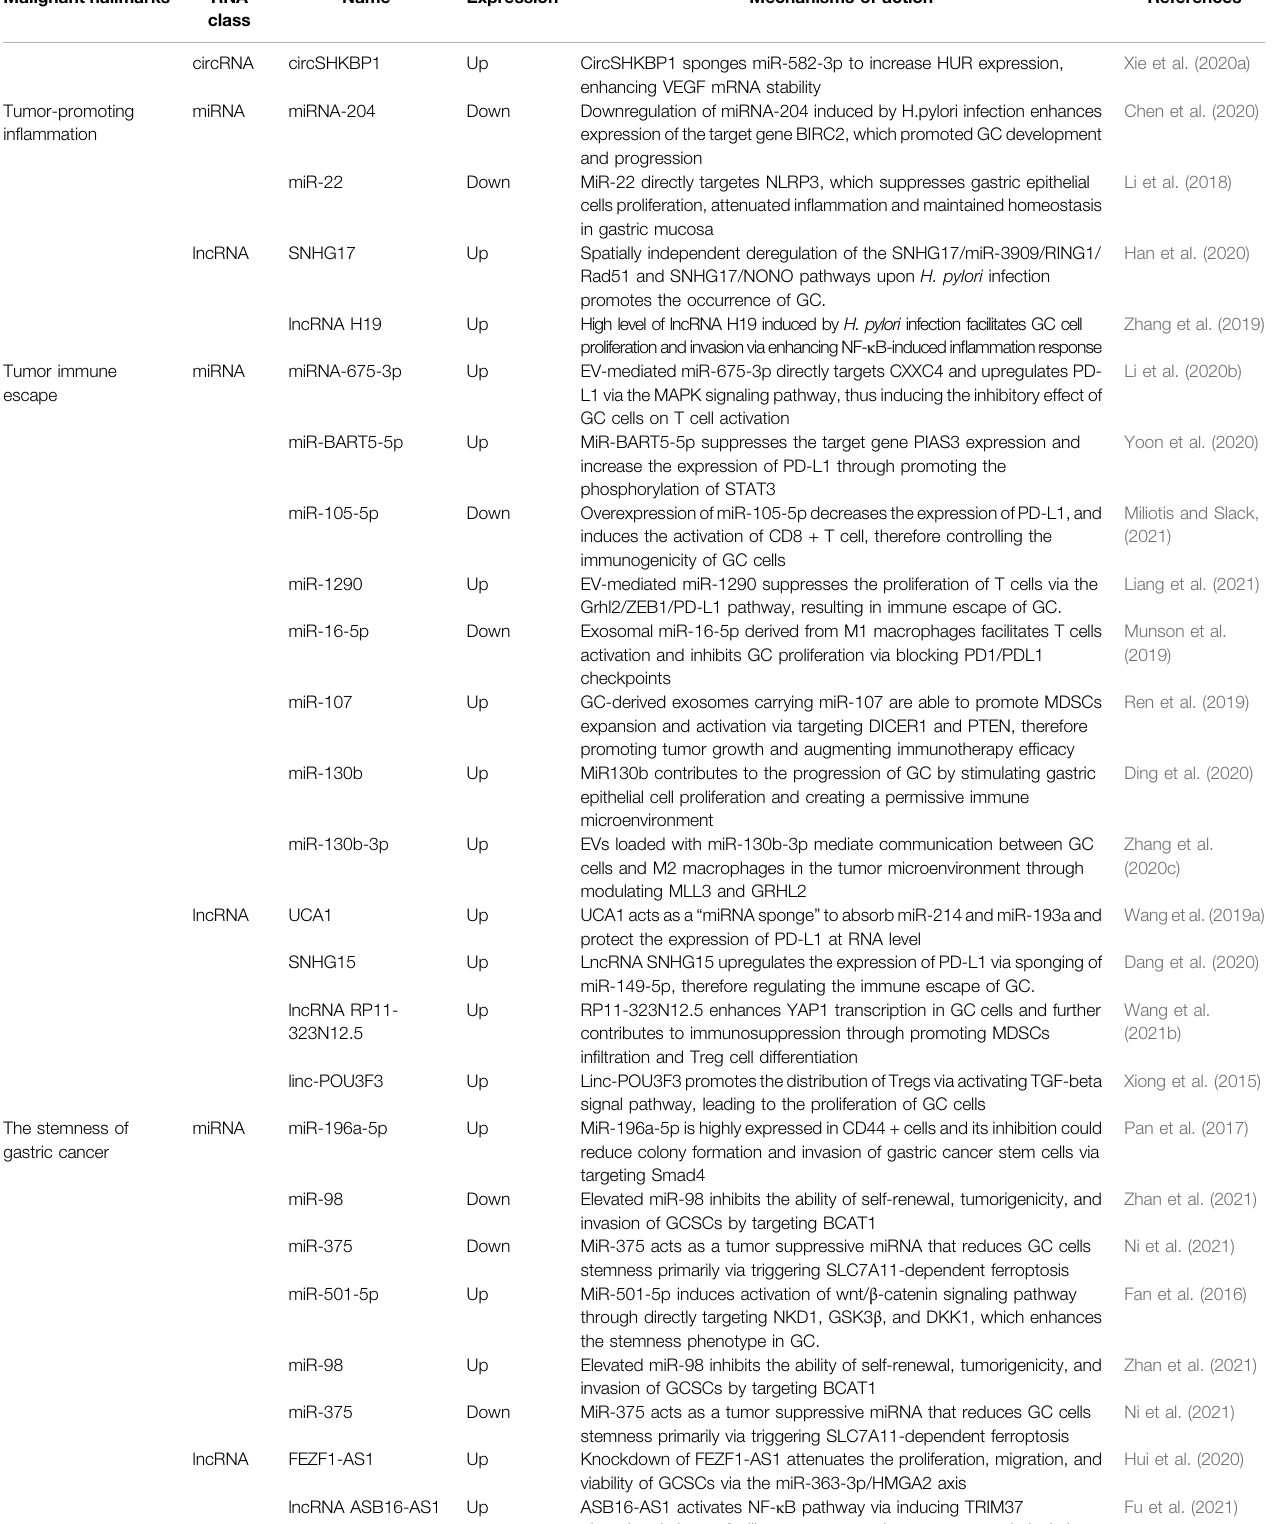
TABLE 1 | ( Continued ) The relationship between ncRNAs and the malignant hallmarks of